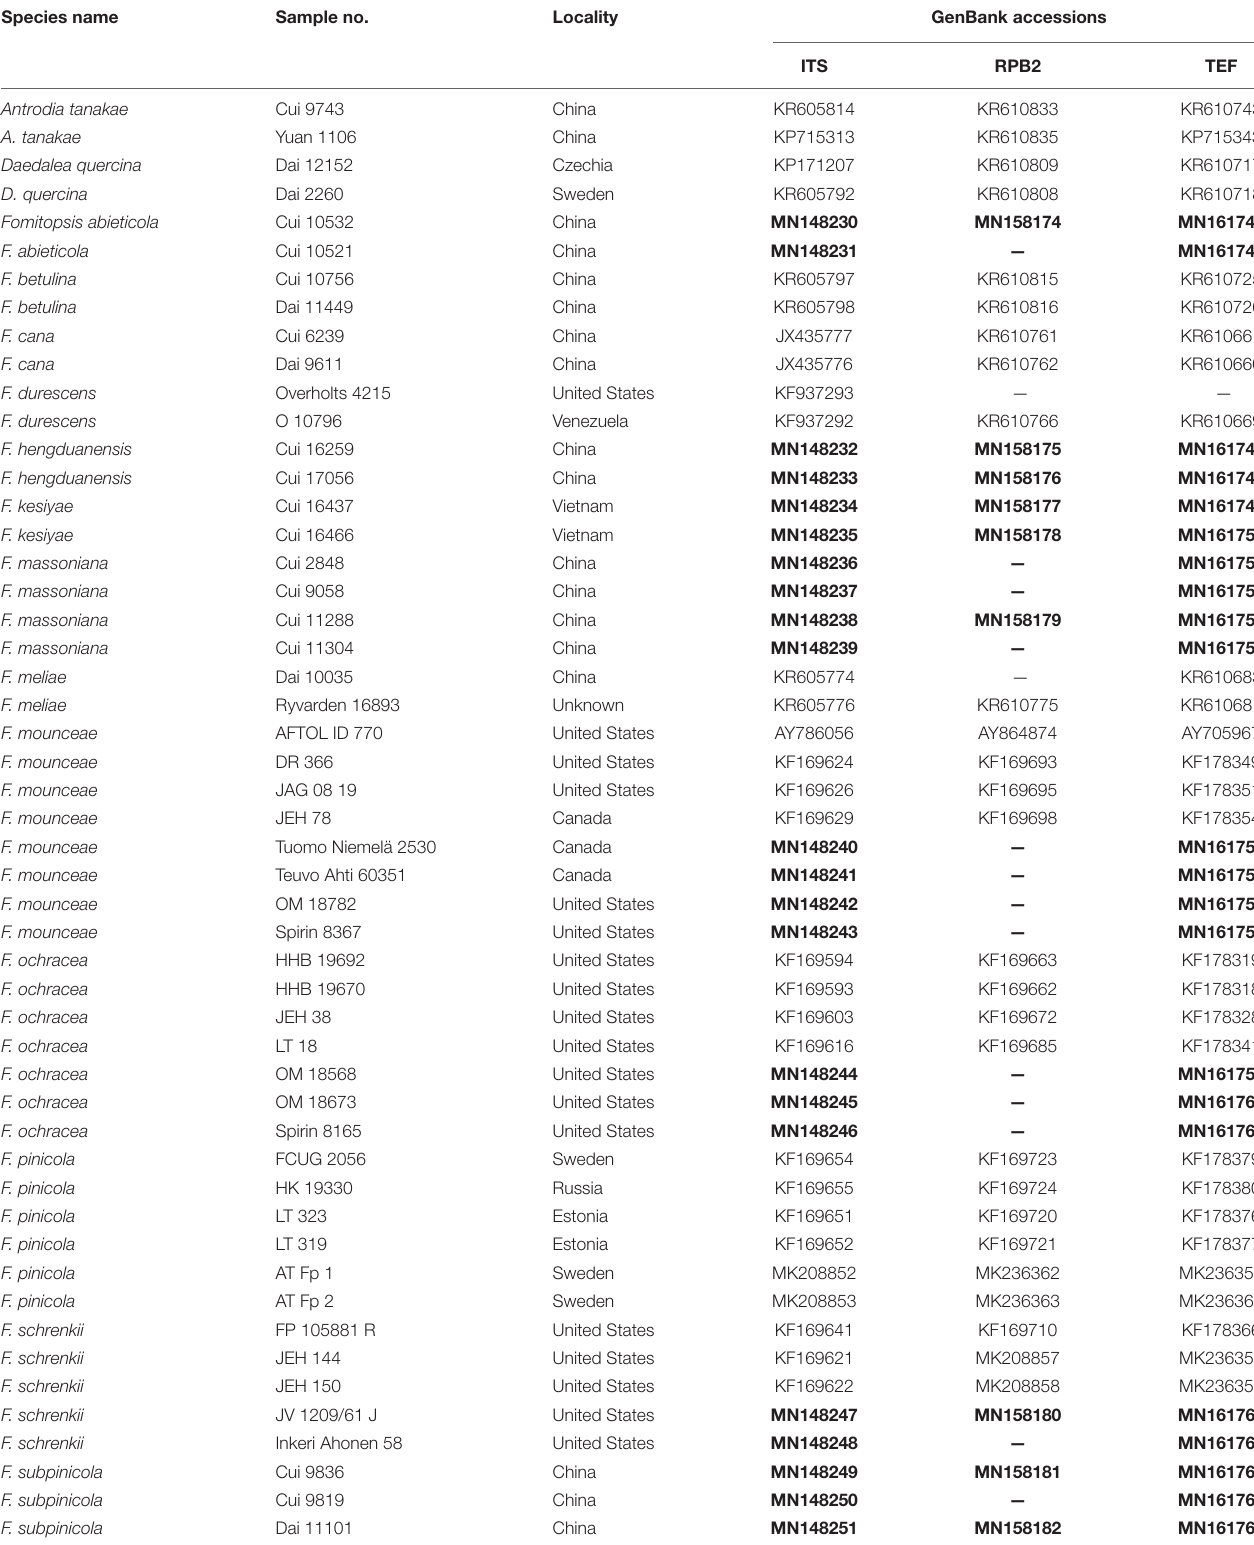
TABLE 1 | A list of species, specimens, and GenBank accession numbers of sequences used in this study. Sample